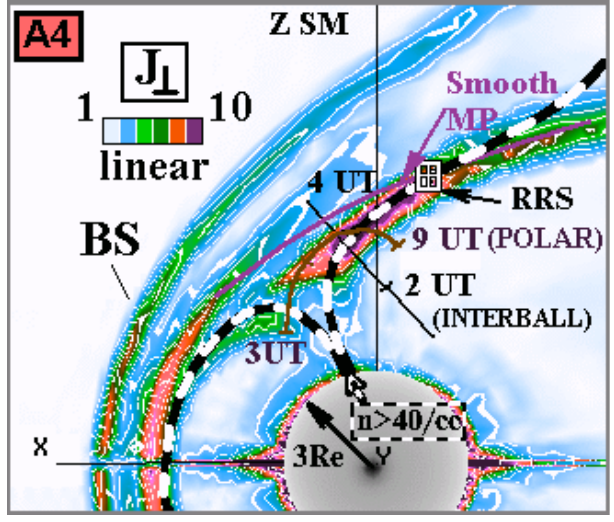
Plate A4. The distribution of the currents perpendicular to the mag- netic field in the noon meridian plane in SM coordinates depicted by the color scale from the global MHD model by Fedder et al. (1995). The projections of the Polar (brown trace) and Interball-1 (black trace) orbits onto that plane (Polar crossed this plane at 05:30UT) are also shown. The dayside magnetopause (MP) and bow shock (BS) are seen in the current maxima at low latitudes, the higher lati- tude smooth MP from Sibeck et al. (1991) model is depicted by the violet line. The global MHD model determined “remote” (from the cusp) reconnection site (RRS) position is shown by a white squared cross. The model inward boundary of the MSH plasma with density > 40/cc is shown by a thick black-and-white dashed line (see also Fig. 7 in Russell et al.,